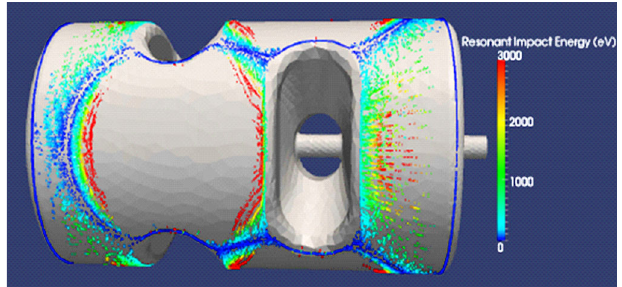
FIG. 34. Resonant electrons and their energies for field levels from 0.5–10 MV.